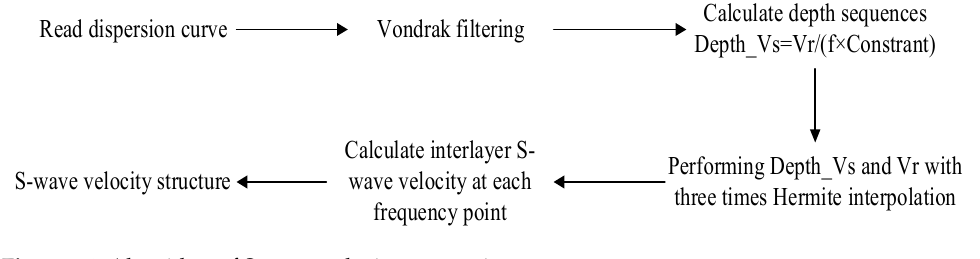
Figure 14. Algorithm of S-wave velocity conversion.